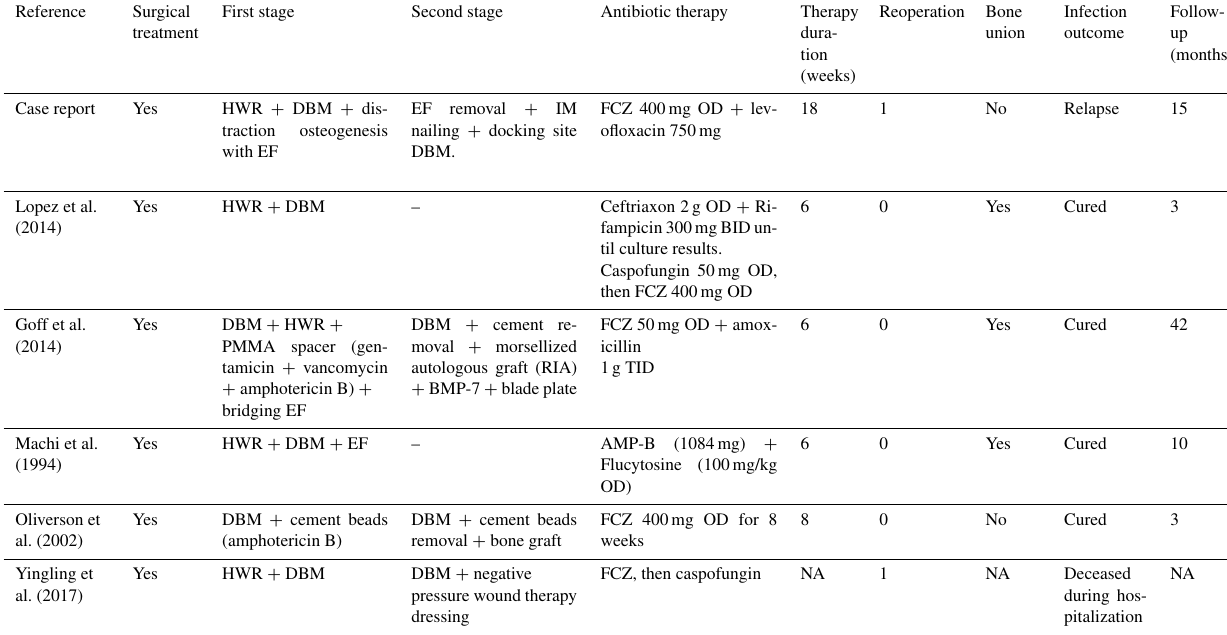
Table 2. Treatment features of reported cases of CFRI in the literature. EF: external fixator; IM: intra-medullary; HWR: hardware removal; DBM: debridement; BMP: bone morphogenetic protein; OD: once daily; BID: twice a day; TID: three times a day; AMP-B: amphotericin-B deoxycholate; FCZ: fluconazole. NA – not